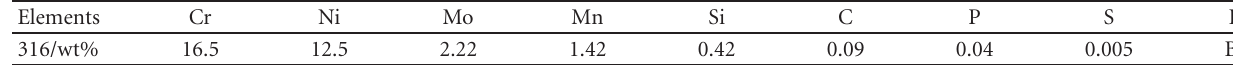
Table 1: Nominal chemical composition of 316.